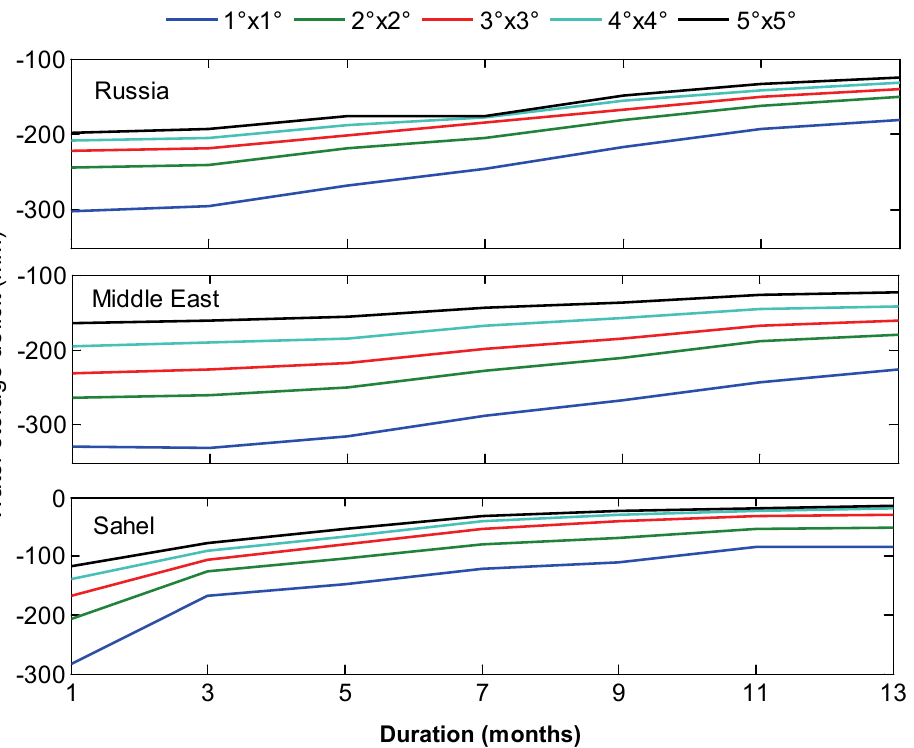
Fig. 2 Water storage deficit–duration–area curves: Russia (top), Middle East (centre) and Sahel (bottom). Storage deficits are displayed on the Y-axis, duration on the X-axis and the coloured lines correspond to different aggregated